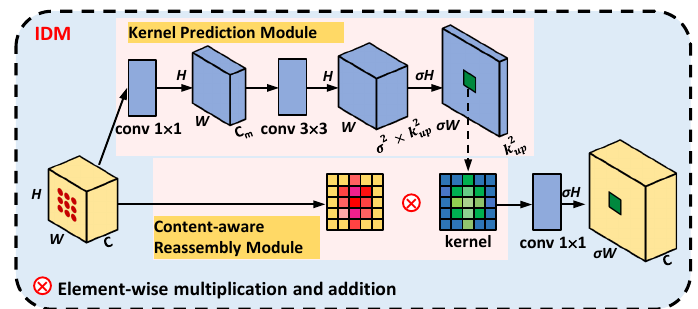
Figure 9. Detailed IDM design of the